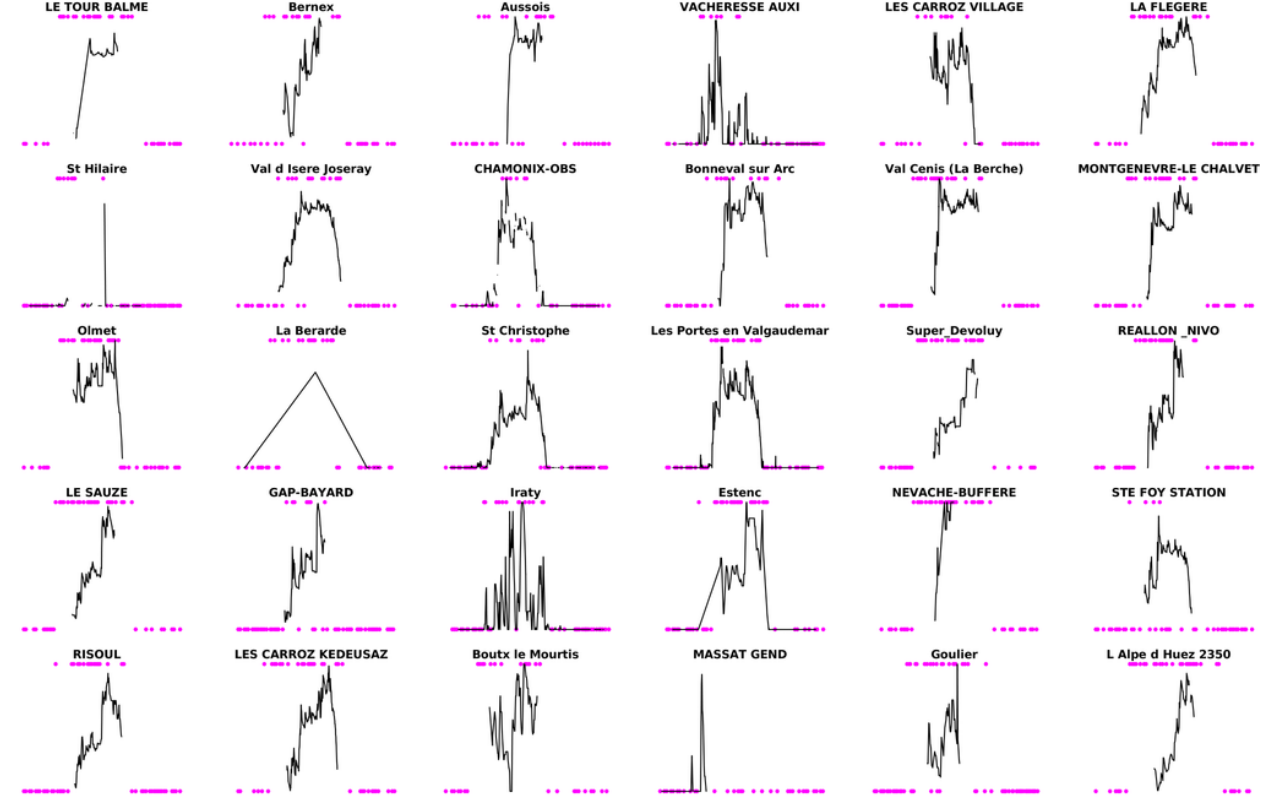
Figure B1. Magenta dots: snow presence (a) or absence (b) in the Theia snow collection. Black line: snow depth time series.